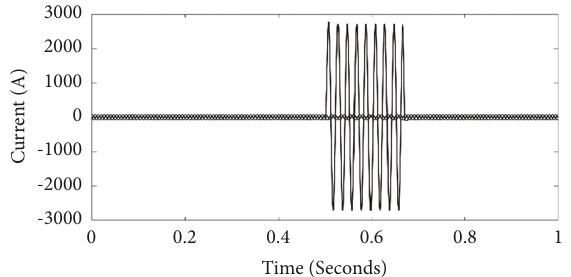
Figure 4: current signal during short circuit fault.